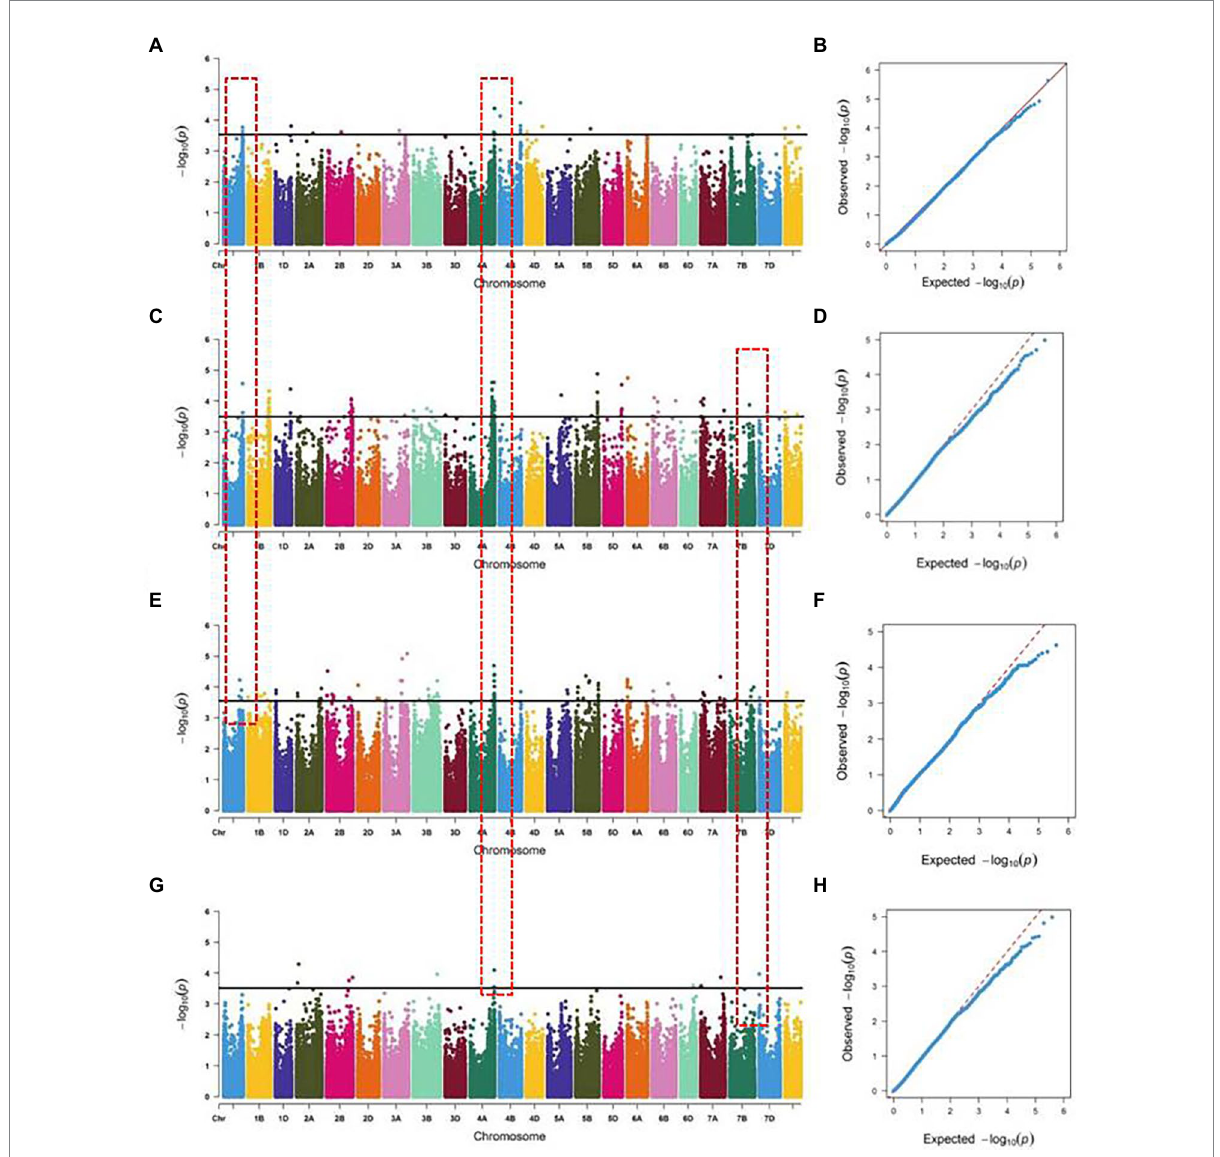
FIGURE 2 Quantile-quantile plots and Manhattan plots for radicle length across 196 accessions and SNP chromosome locations. (A,B) Wheat hydroponically grown in greenhouse; (C,D) Wheat hydroponically grown outdoor in 2017; (E,F) Wheat hydroponically grown outdoor in 2018; (G,H) Wheat hydroponically grown outdoor in